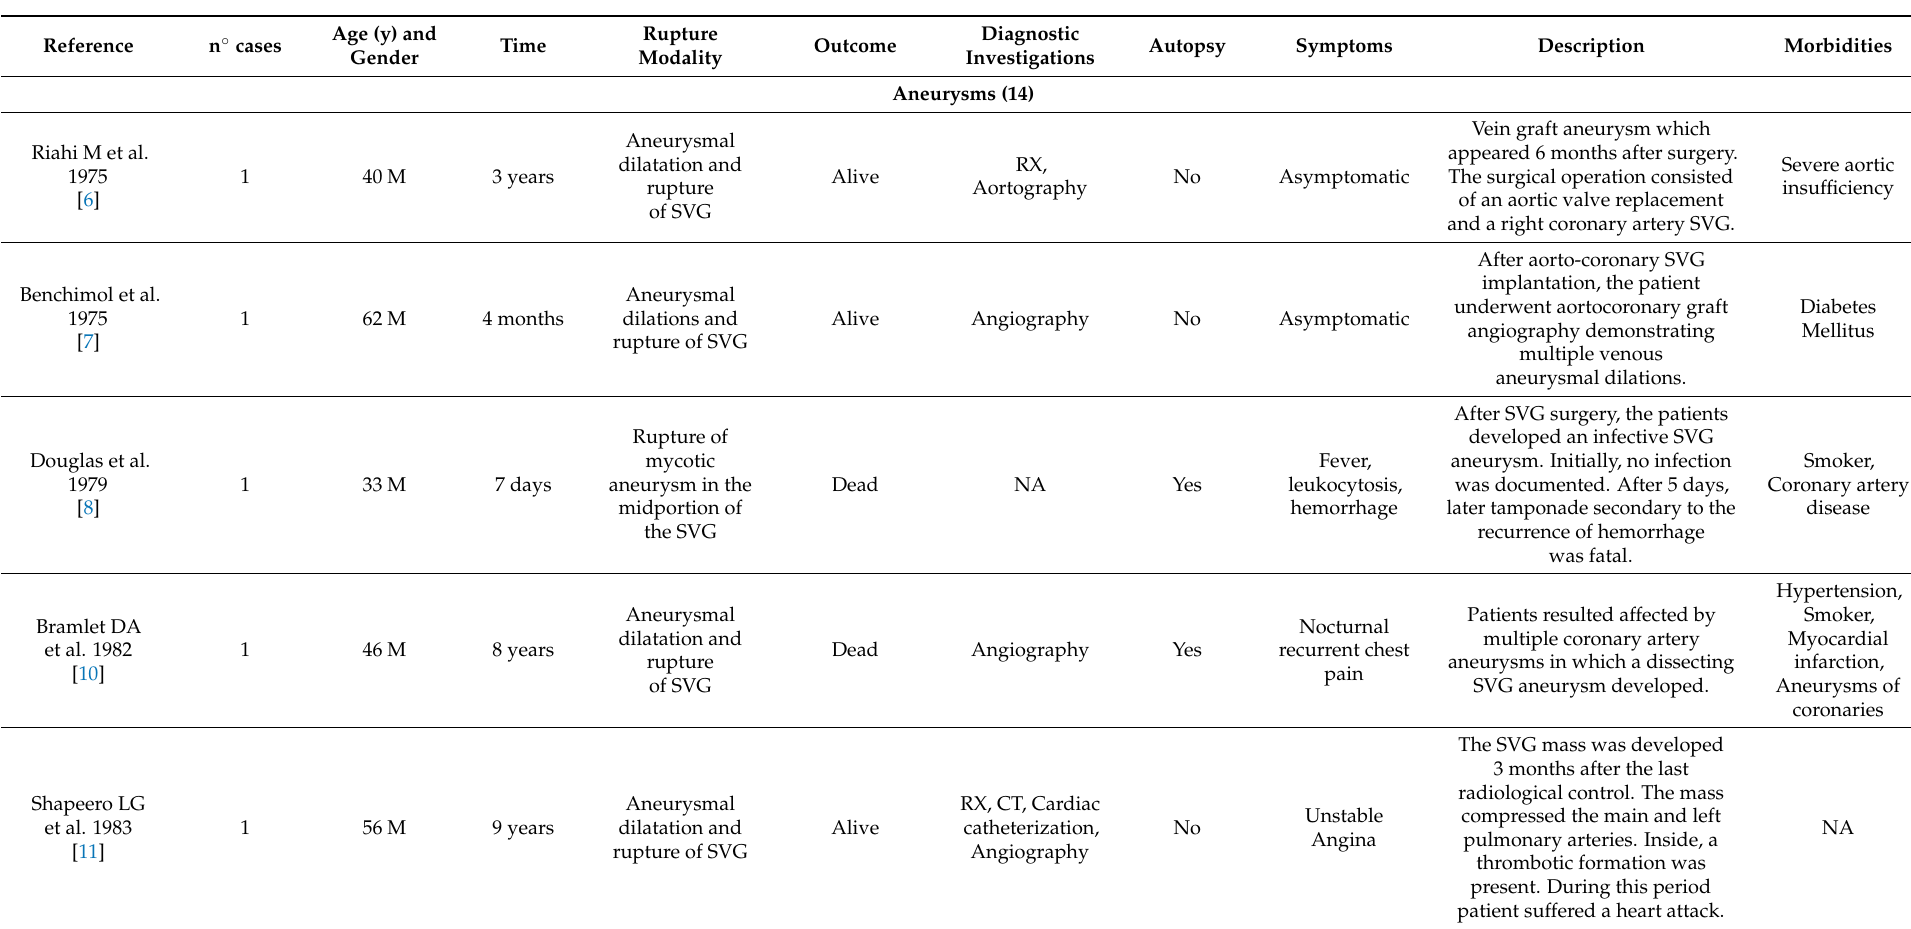
Table 1. The table shows 23 cases of SVG aneurysmal or pseudoaneurysmal rupture. In each case, the age, sex, and time of rupture were described. A separate column listed the imaging tests useful for diagnosis and the patients’